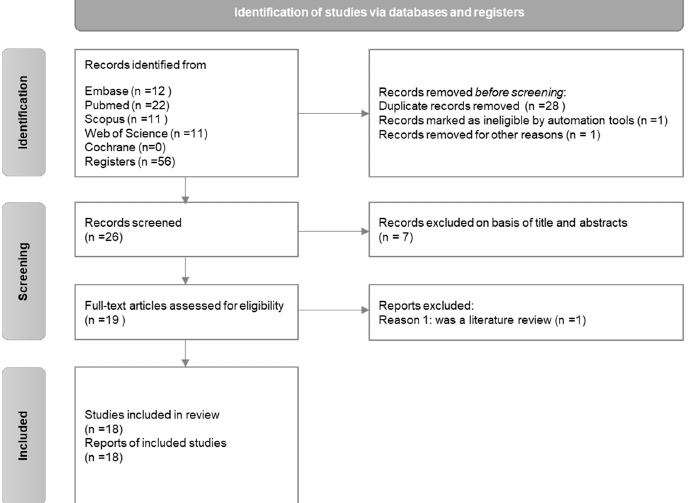
Figure 1. Flowchart showing the identi fi cation of studies via databases and registers [12].